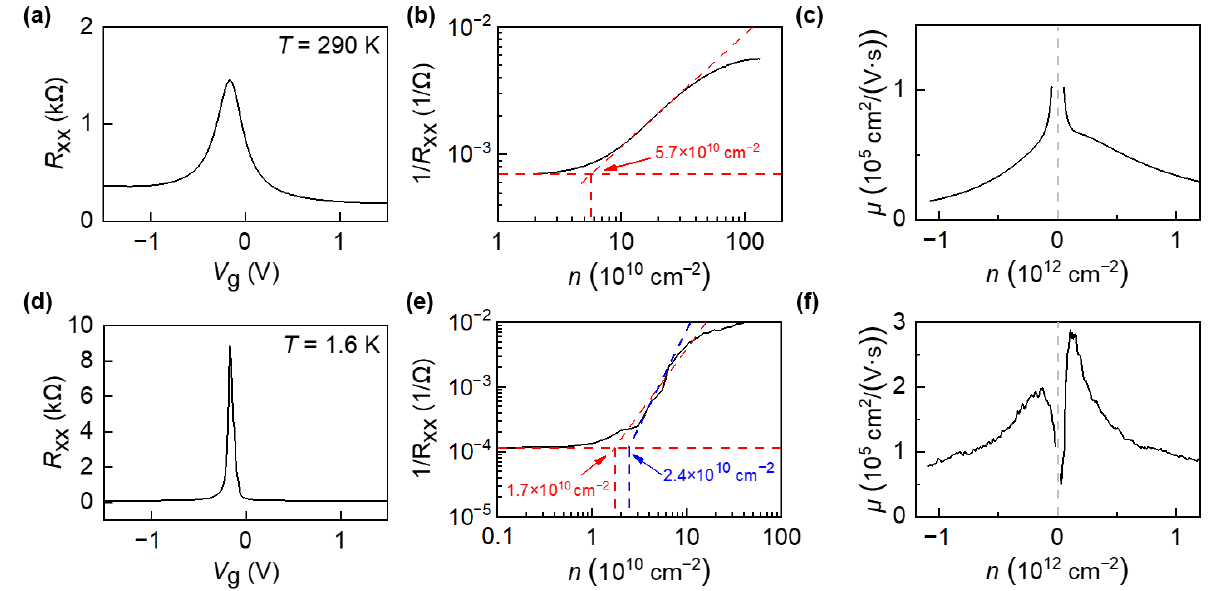
Figure 2. ( a ) Longitudinal resistance R xx as a function of gate voltage ( V g ) at 290 K under small ac bias current (100 nA). ( b ) The inverse longitudinal resistance R xx as a function of the charge carrier density n . The residual charge carrier fluctuation is calculated by the intercept of two lines. ( c ) Carrier mobility µ as function of charge carrier density n for | n | > 5.7 × 10 10 cm − 2 . ( d , e ) Same as ( a , b ), but measured at T = 1.6 K. ( f ) Carrier mobility µ as a function of charge carrier density n for | n | > 1.7 × 10 10 cm − 2 ~2.4 × 10 10 cm − 2